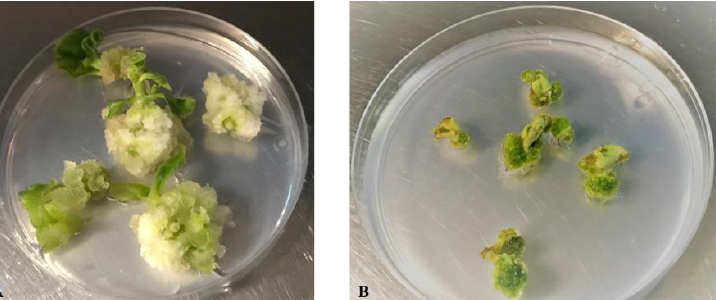
Figure 1. Morphogenetic behavior of A. oleracea nodal ( A ) and leaf ( B ) explants after 30 days of culture on LS medium supplemented with 1 mg/L 6-Benzylaminopurine (BAP) and 0.1 mg/L 1-Naphthaleneacetic acid (NAA) (LS1 regeneration medium).